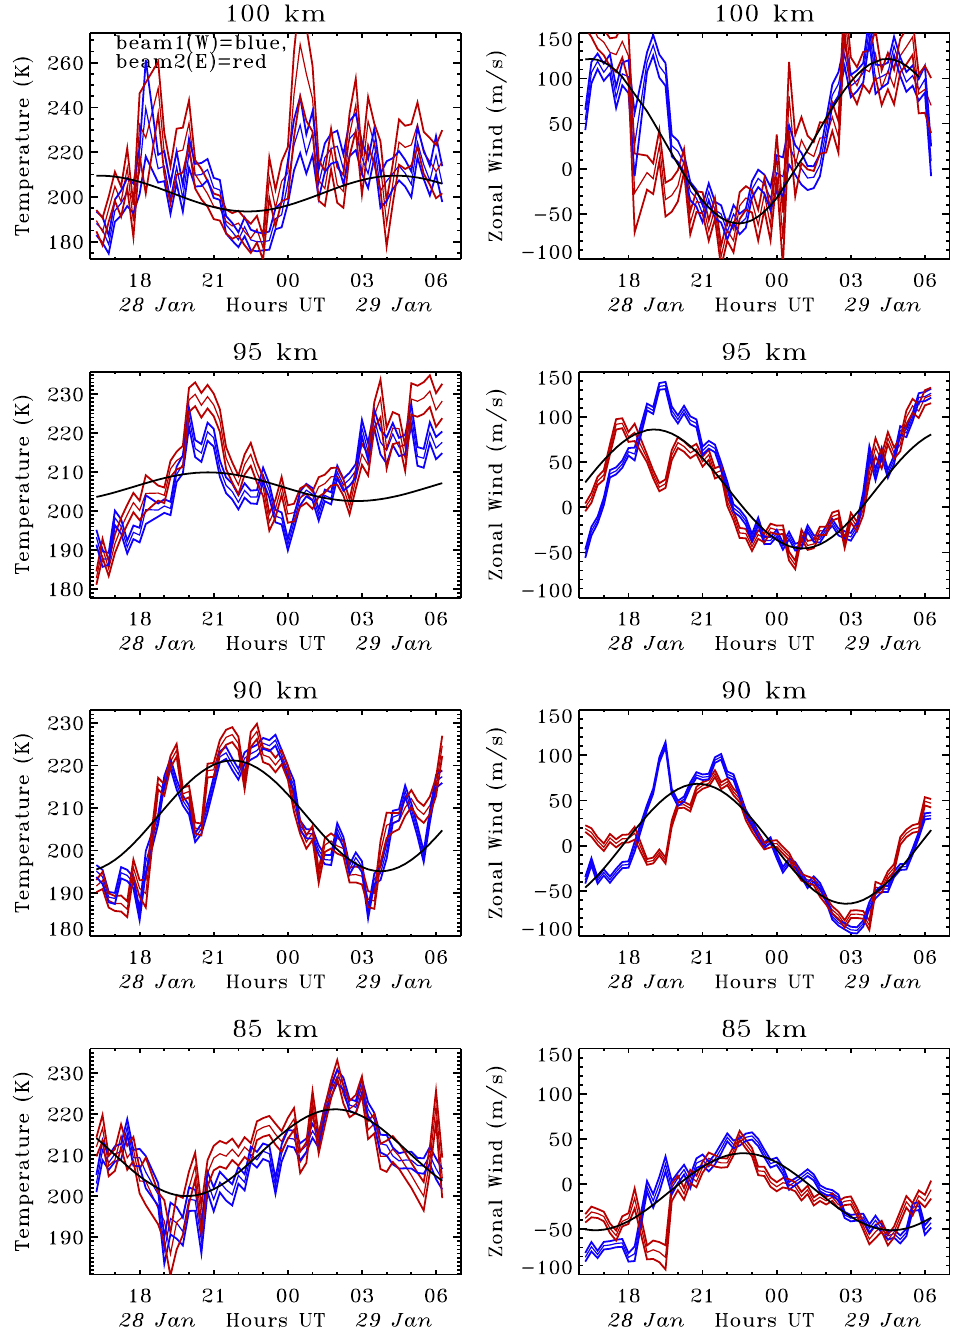
Fig. 2. Time series of zonal wind (right column) and temperature (left column) for beam 1 (20W, blue) and beam 2 (20E, red) for 4 altitudes with errors and the semidiurnal fit (black